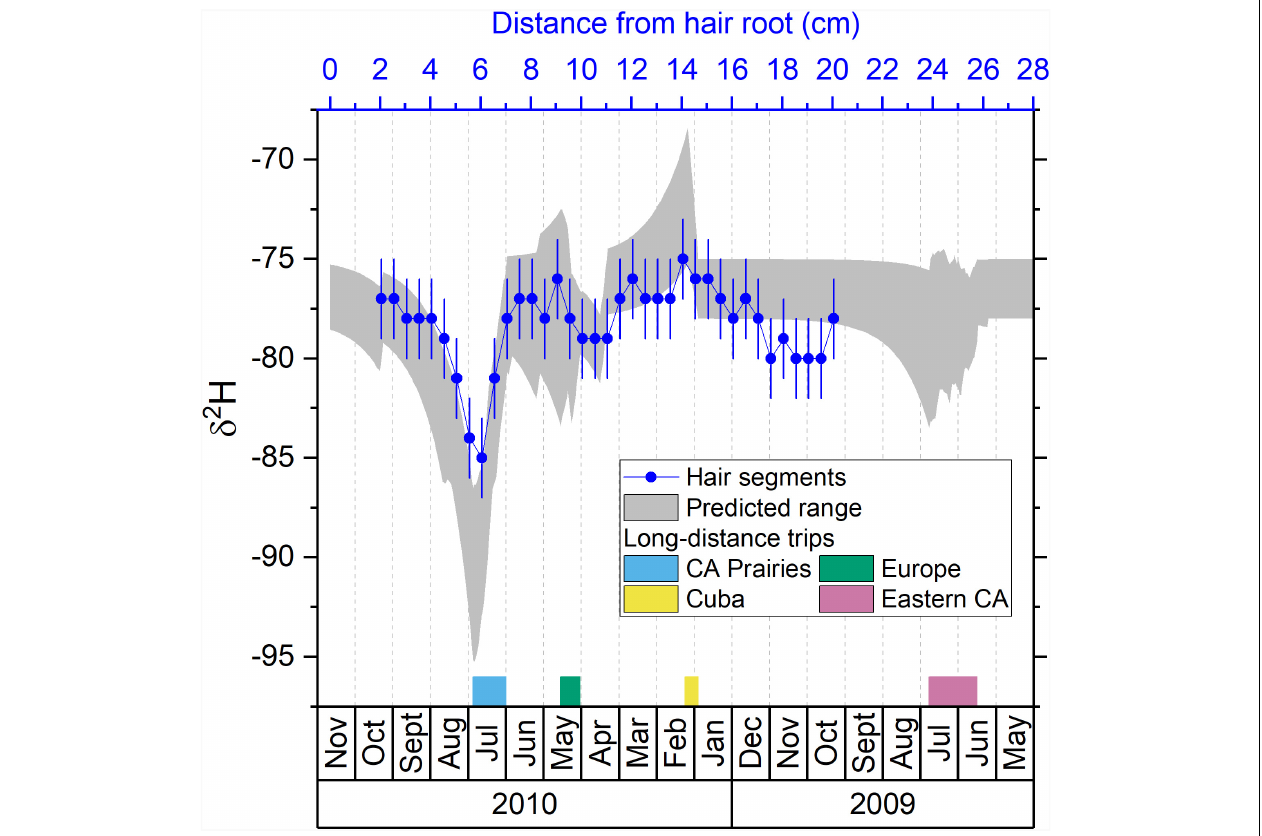
FIGURE 2 | Comparison between the predicted isotopic profile and the measured isotopic values in hair segments for hydrogen. Blue dots are the measured δ 2 H values in hair segments versus their distances from the hair root (top axis) . The shaded area is the predicted range of δ 2 H values in hair versus the date (bottom axis) . The periods of the four major trips are marked with colored bars next to the bottom